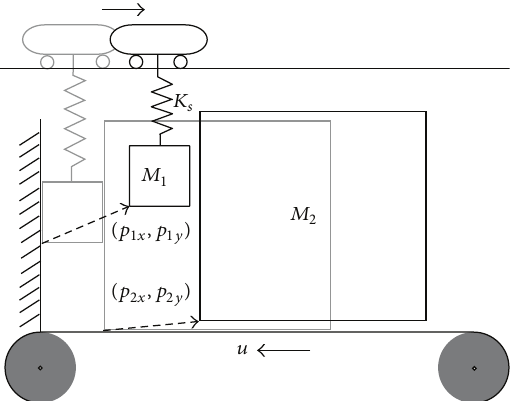
Figure 8: Example II: multiple frictional-unilateral contacts. In the simulation, the parameters were chosen as 𝜇 1 = 𝜇 2 = 𝜇 3 = 0.5 , 𝑀 1 = = 1 kg, 𝐾 = 100 N/m, and 𝑢 = 1 m/s, and the initial 0.5 kg, 𝑀 2 𝑠 conditions are 𝑝 = [0, 0.25, 0.05, 0] 𝑇 m, and ̇𝑝 = [0, 0,0, 0] 𝑇